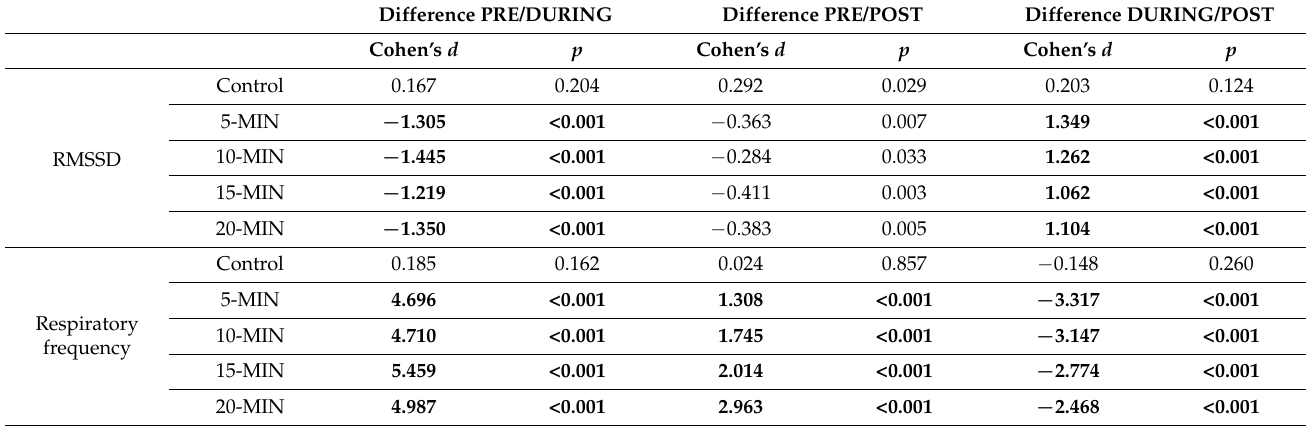
Table 2. Mean comparisons regarding time—pre, during, and